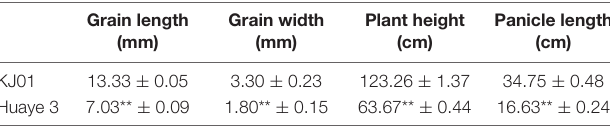
TABLE 1 | Phenotypic value of traits for KJ01 and Huaye 3.